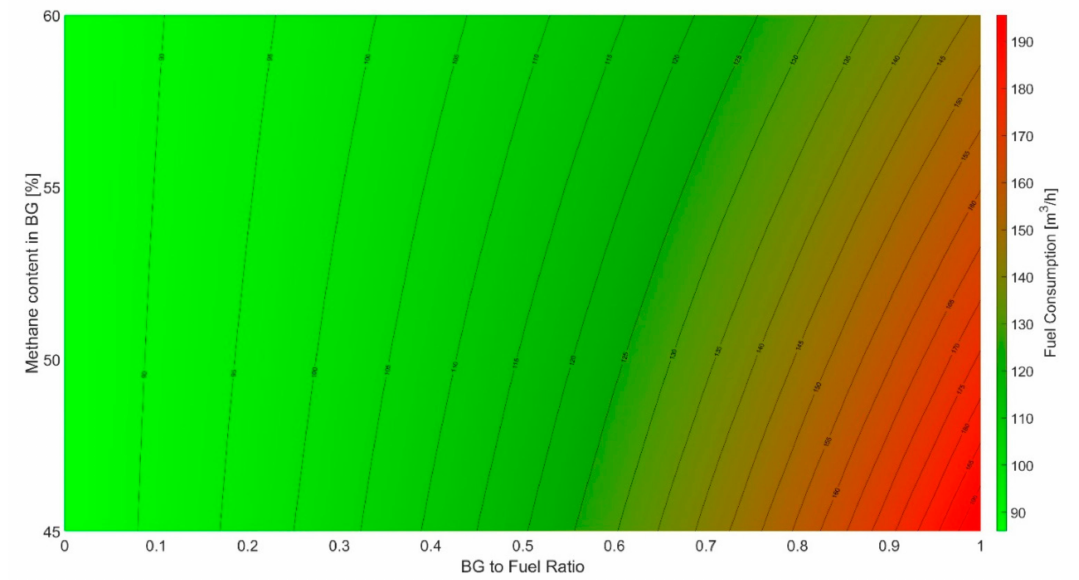
Figure 7. Total boiler fuel consumption as a function of biogas-to-fuel ratio and methane content in